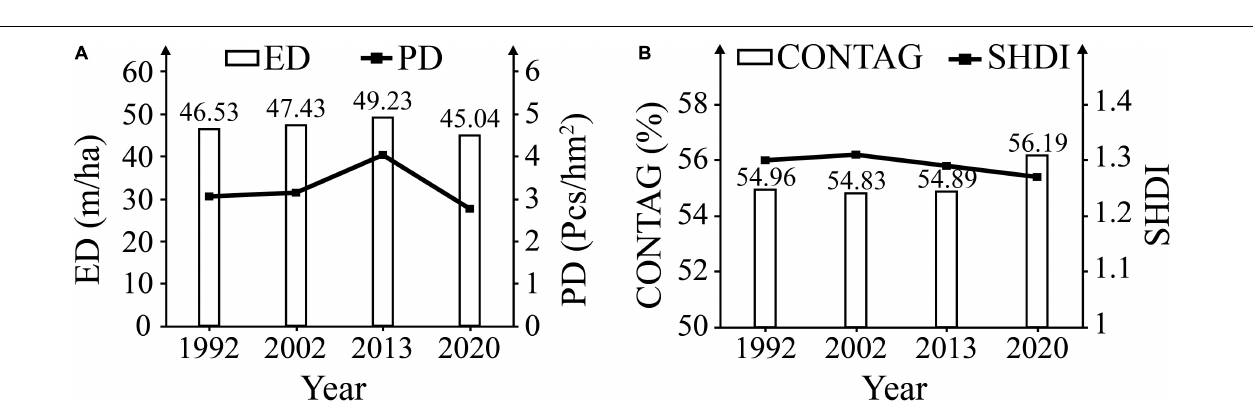
FIGURE 4 | Landscape pattern metrics of the Changshagongma Wetland Nature Reserve at the class level during the four time periods. (A) Percentage of landscape (PLAND), (B) patch density (PD), (C) aggregation index (AI), and (D) mean fractal dimension (FRAC_MN).